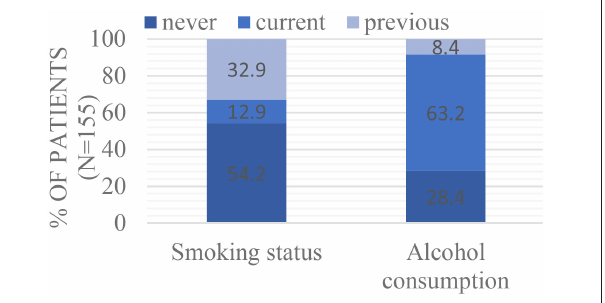
FIGURE 2 | Smoking status and alcohol